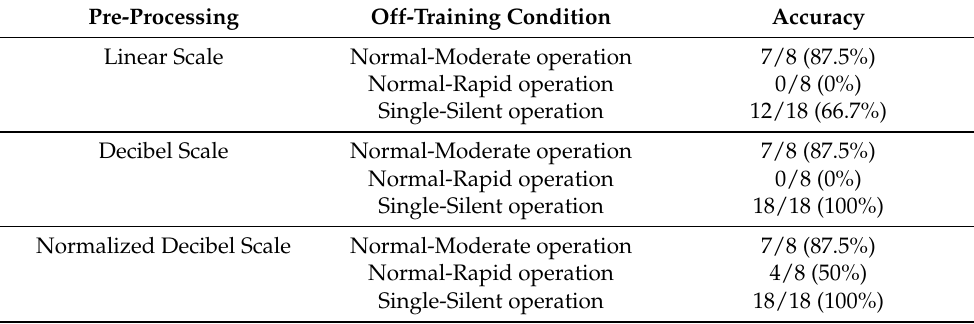
Table 8. Comparing the accuracy of neural networks in off-training